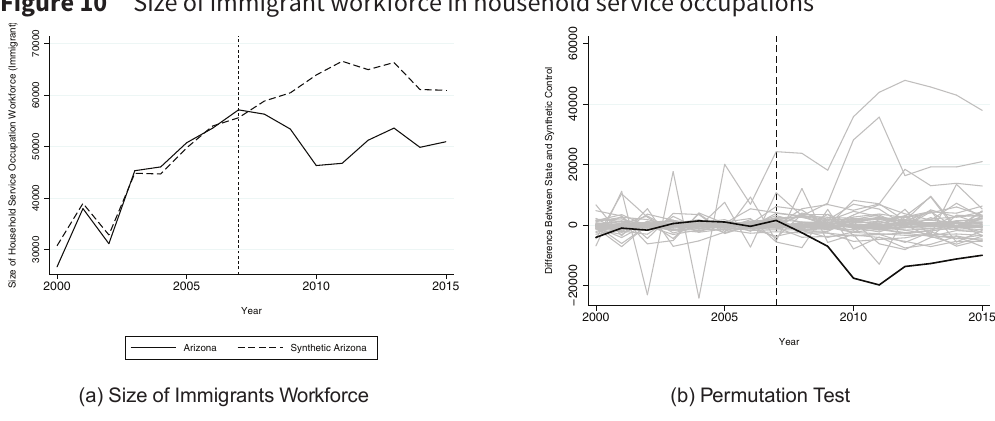
Size of immigrant workforce in household service